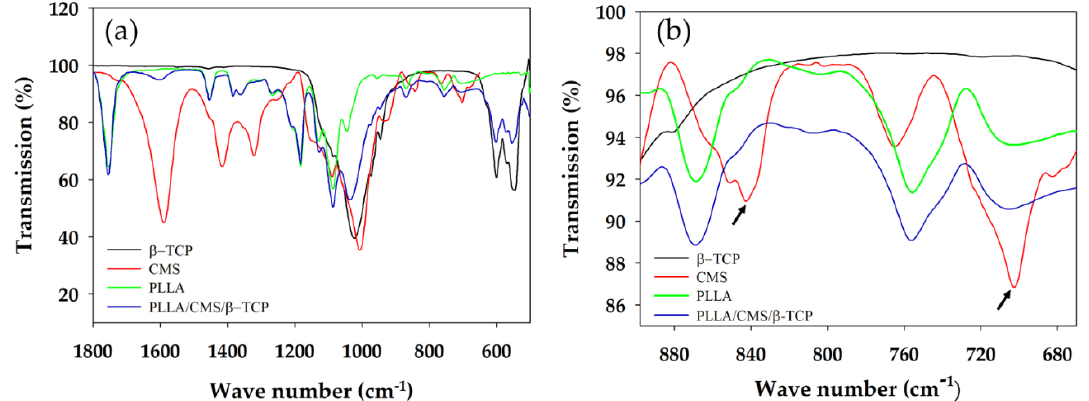
Figure 8. IR absorption peak of composite nanofibers ( a ) Intensity changes and budging and ( b ) peak vanishing (arrow) at the CMS spectrum after the addition of β -TCP particles.